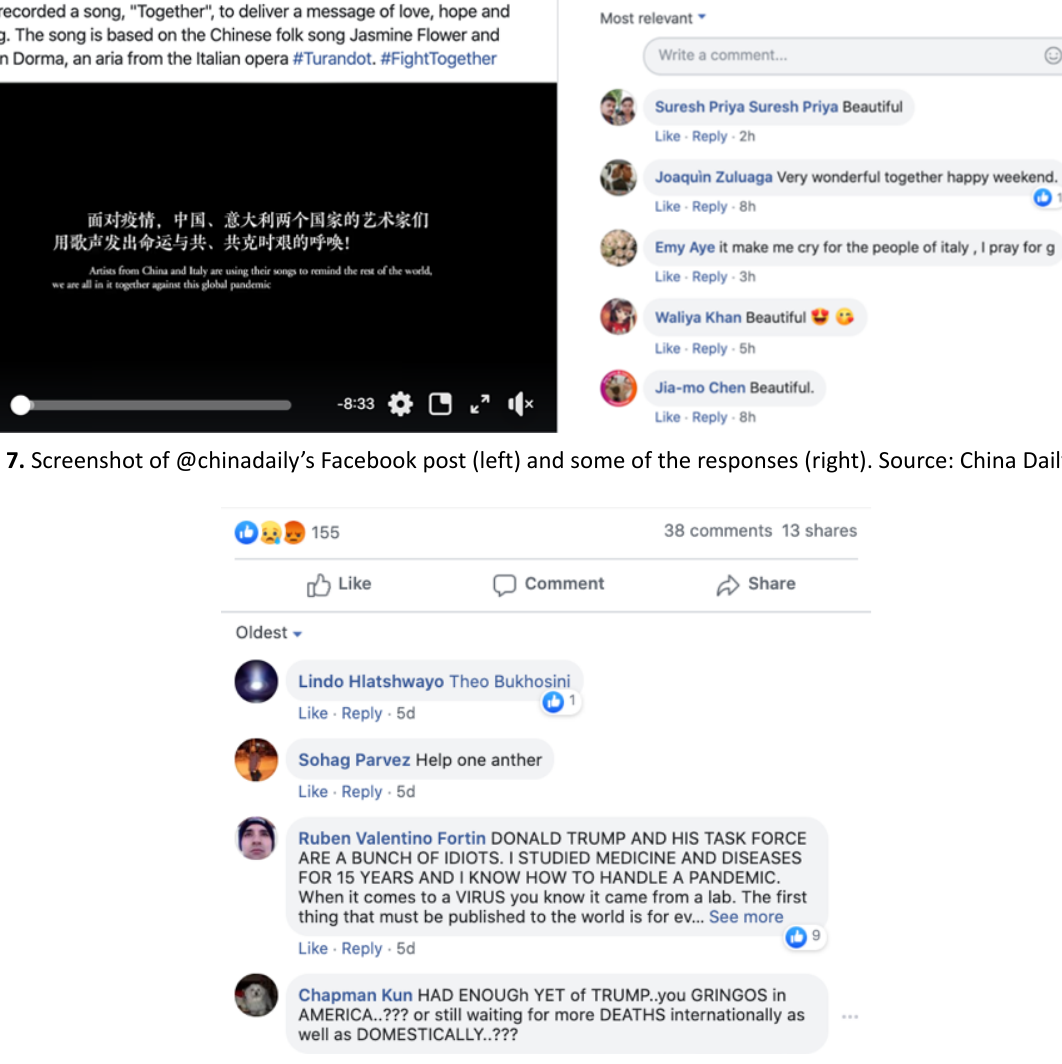
Figure 8. Screenshot of some of the responses to the post in Figure 4. Source: CGTN America (2020). Media and Communication, 2020, Volume 8, Issue 2, Pages